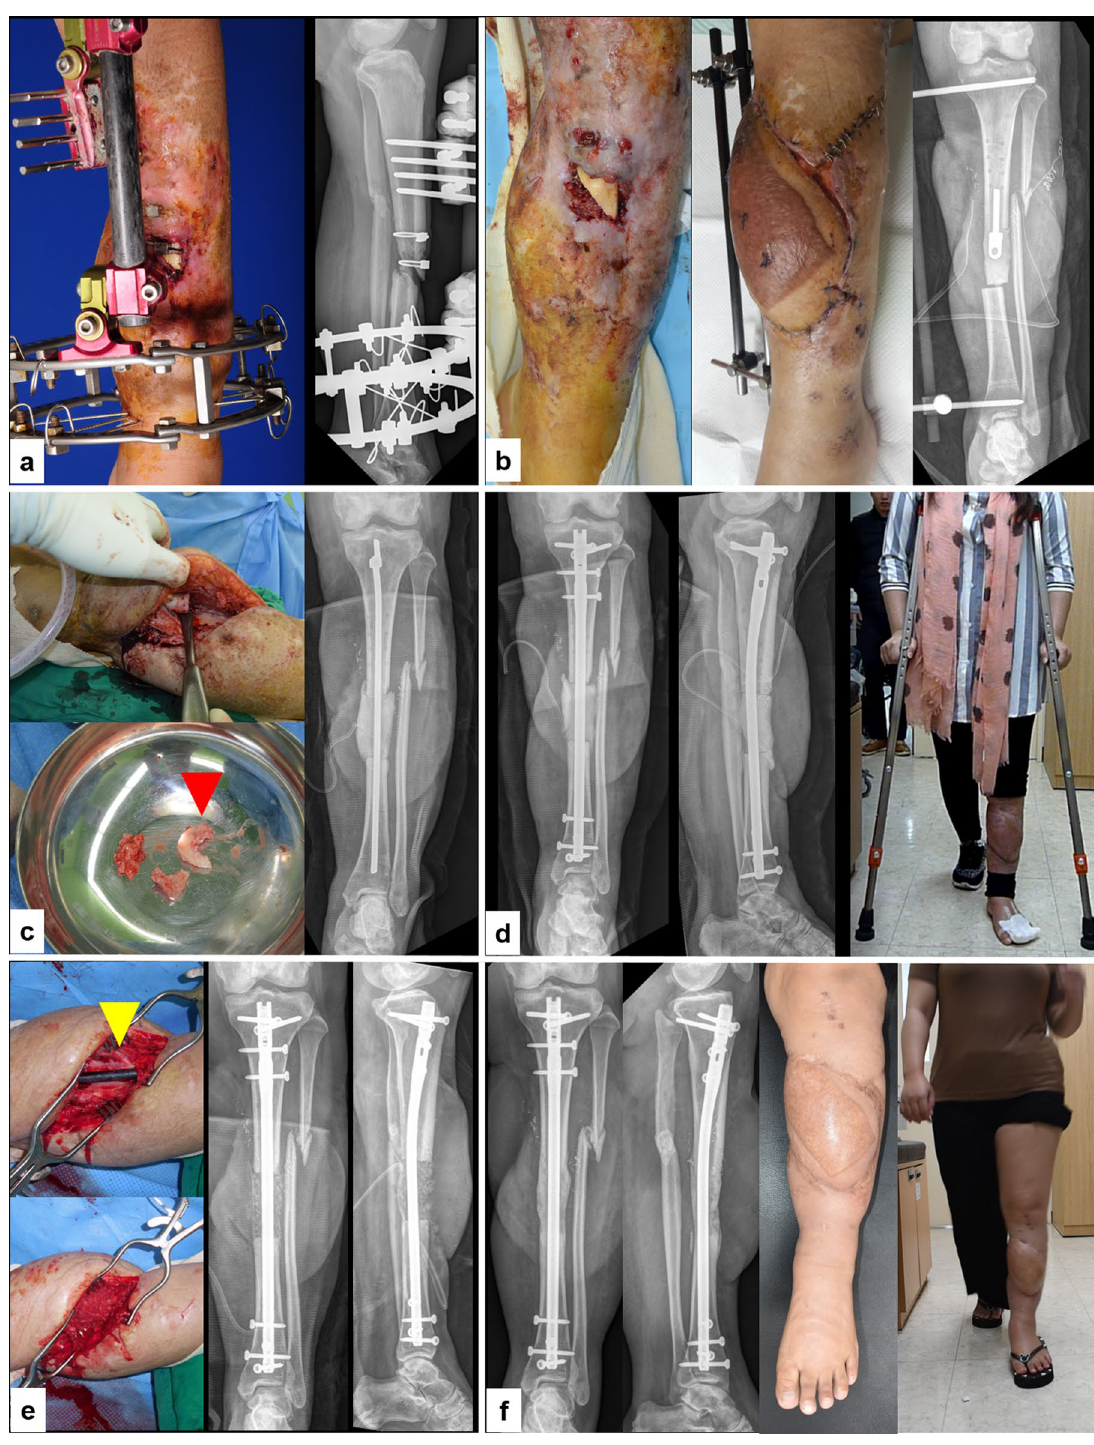
Figure 6. ( a ) A 24-year-old female patient sustained a recalcitrant infected nonunion of the left tibia. ( b ) According to the Multi-staged IMT protocol, we performed thorough debridement, placed an antibiotic-loaded PMMA spacer, and provided temporary bony stabilization. Soft tissue defects were covered using an anterolateral thigh flap (stage 1). ( c ) As PDCP had been identified at EMP and IMP (pseudomonas and MRSA), targeted debridement at proximal area of bone defect (red arrow head, sequestrum) and temporary fixation using antibiotics loaded PMMA coated intramedullary rod was performed (repetitive stage1). ( d ) After confirming all PDCN at previous stage, definitive fixation using IM nail was performed. An antibiotic-loaded PMMA spacer was reinserted into the bone defect for staged bone grafting to confirm that the infection had been eradicated (stage 2). Prompt partial weight bearing exercise was allowed after definitive fixation. ( e ) The 6-cm sized segmental bone defect was filled with autogenous bone (45 g) and DBM (15 g) in induced membrane chamber (yellow arrow head) at 16 weeks after stage 2 (stage 3). ( f ) Two years follow up radiographs show complete consolidation of the grafted bone without recurrent infection. The injured limb recovered to full